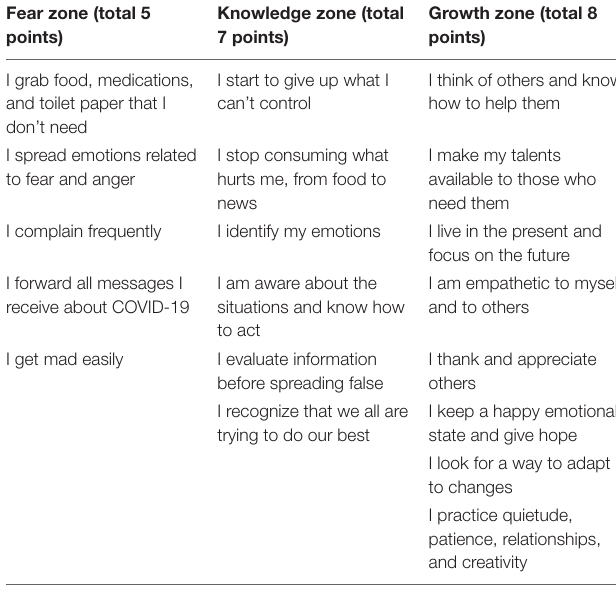
TABLE 1 | Statements used to score COVID-SS for each zone. Each correct statement carries 1